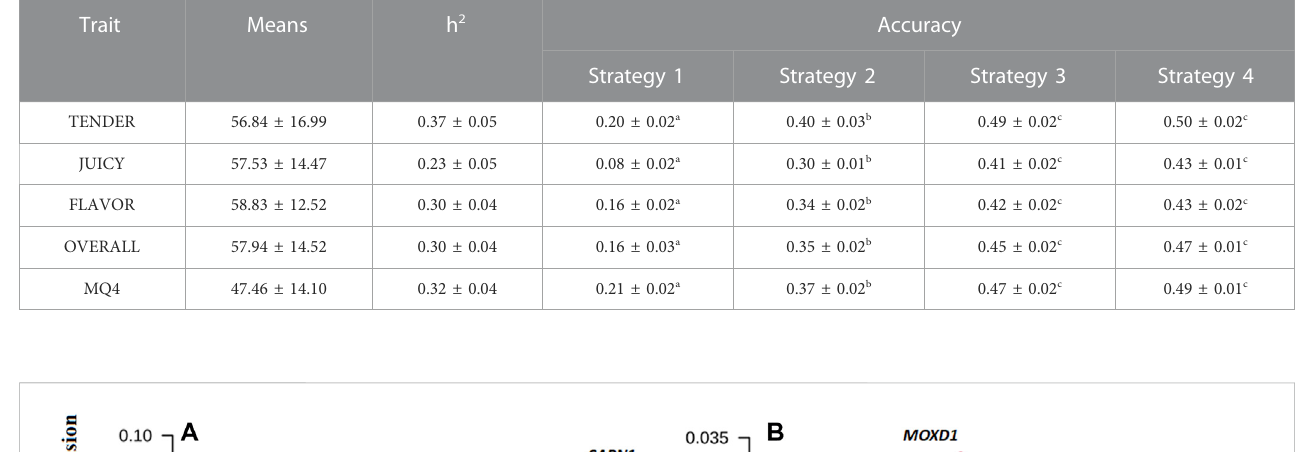
TABLE 1 Means (±standard deviations), heritability (±SE), and accuracy of predicting phenotype (±SE) of phenotype prediction for 5 eating quality traits [tenderness (TENDER), juiciness (JUICY), fl avour (FLAVOR), overall liking (OVERALL), and MQ4 score formed by weighting the four sensory scores]. See methods for description of strategies. The signi fi cant difference of strategies was shown in different letters (a, b, c).